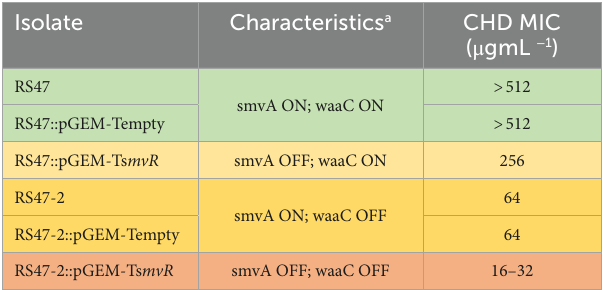
TABLE 2 Relative contribution of smvA efflux and LPS alterations to CHD susceptibility in RS47-2. Isolate Characteristics